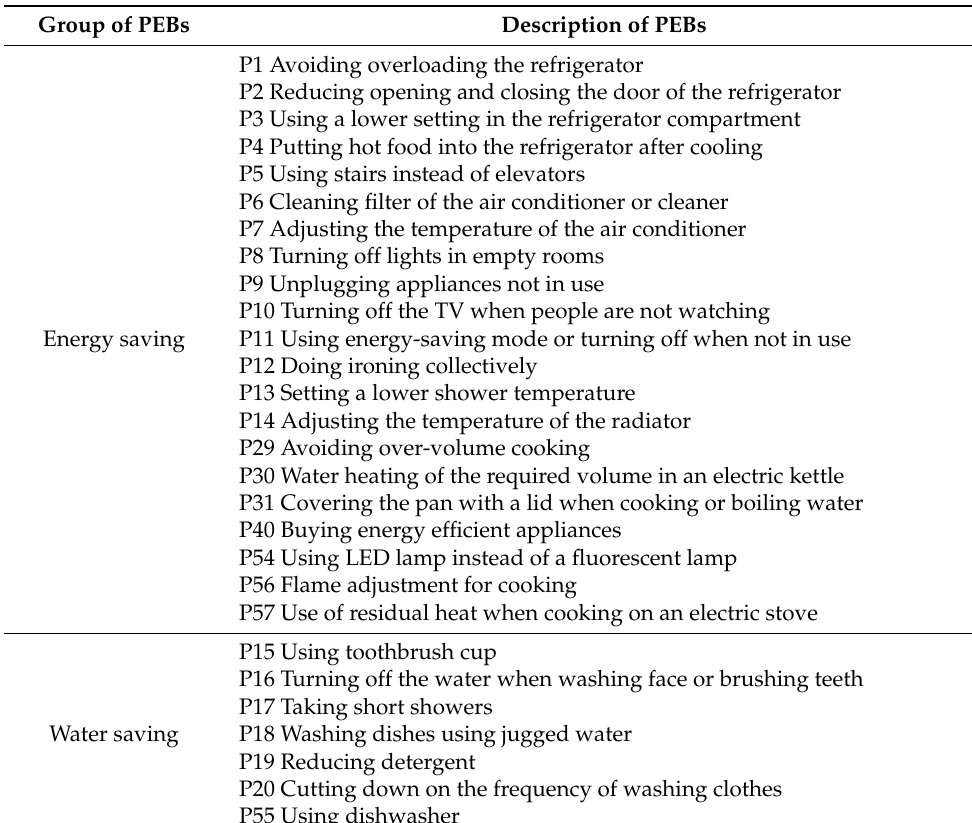
Table 1. Proenvironmental patterns of consumers’